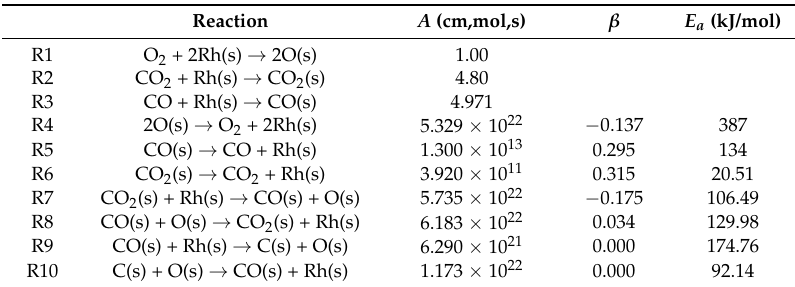
Table 1. Reaction mechanism for CO oxidation on Rh